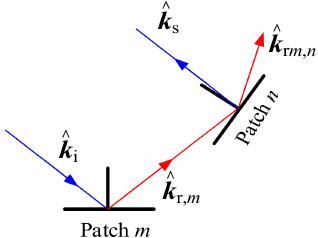
Figure 1. Illustration of the second-order scattering from patch m to patch n